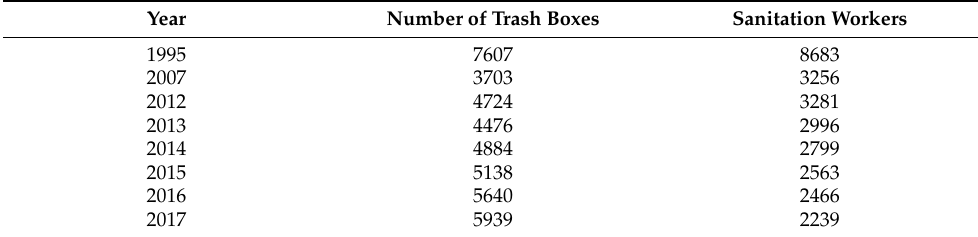
Table 1. The Number of Trash Bins and Sanitation Workers in